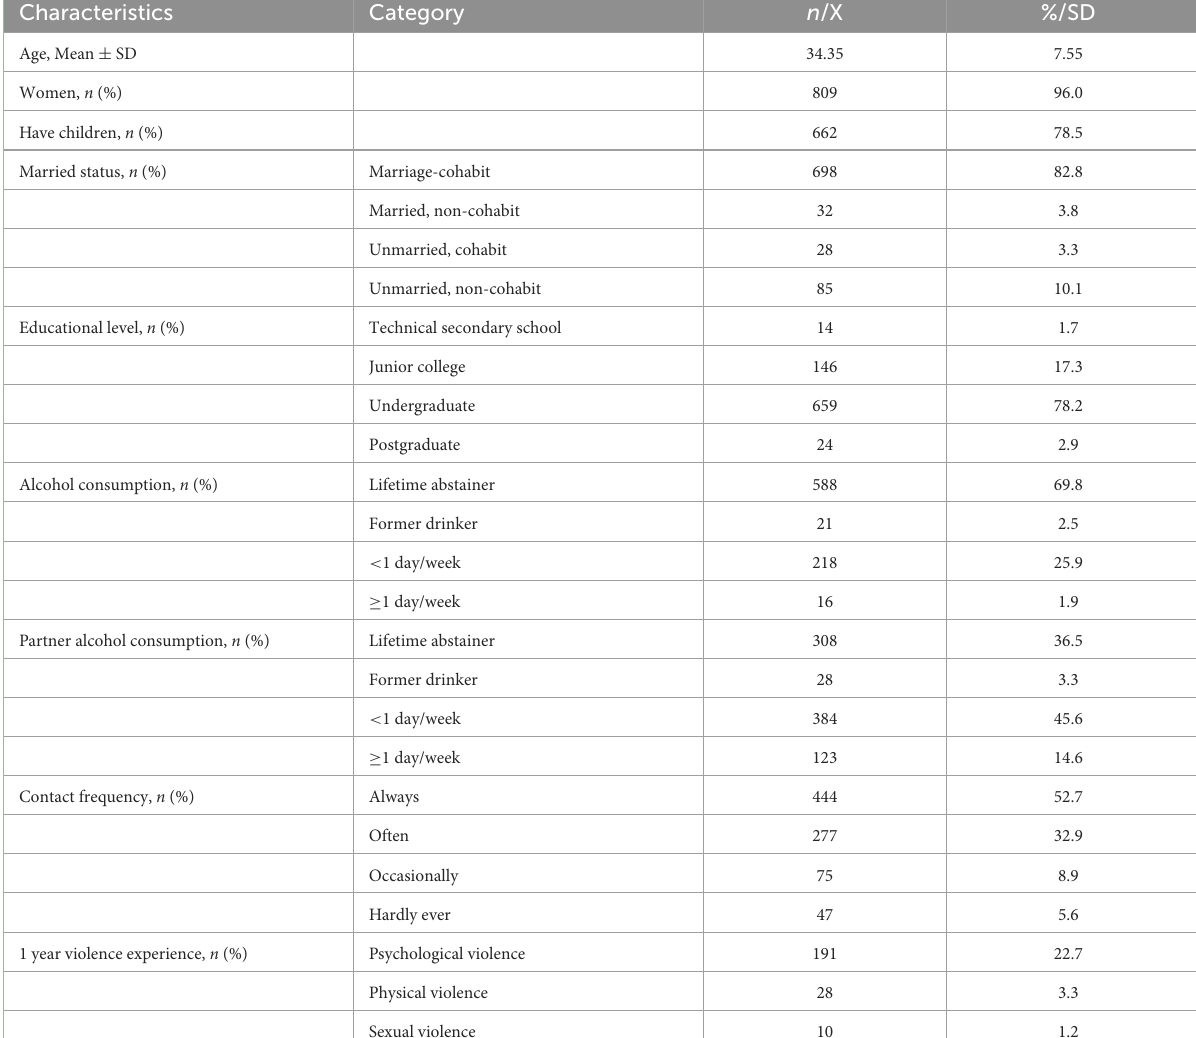
TABLE 1 Demographic characteristics, n = 843.